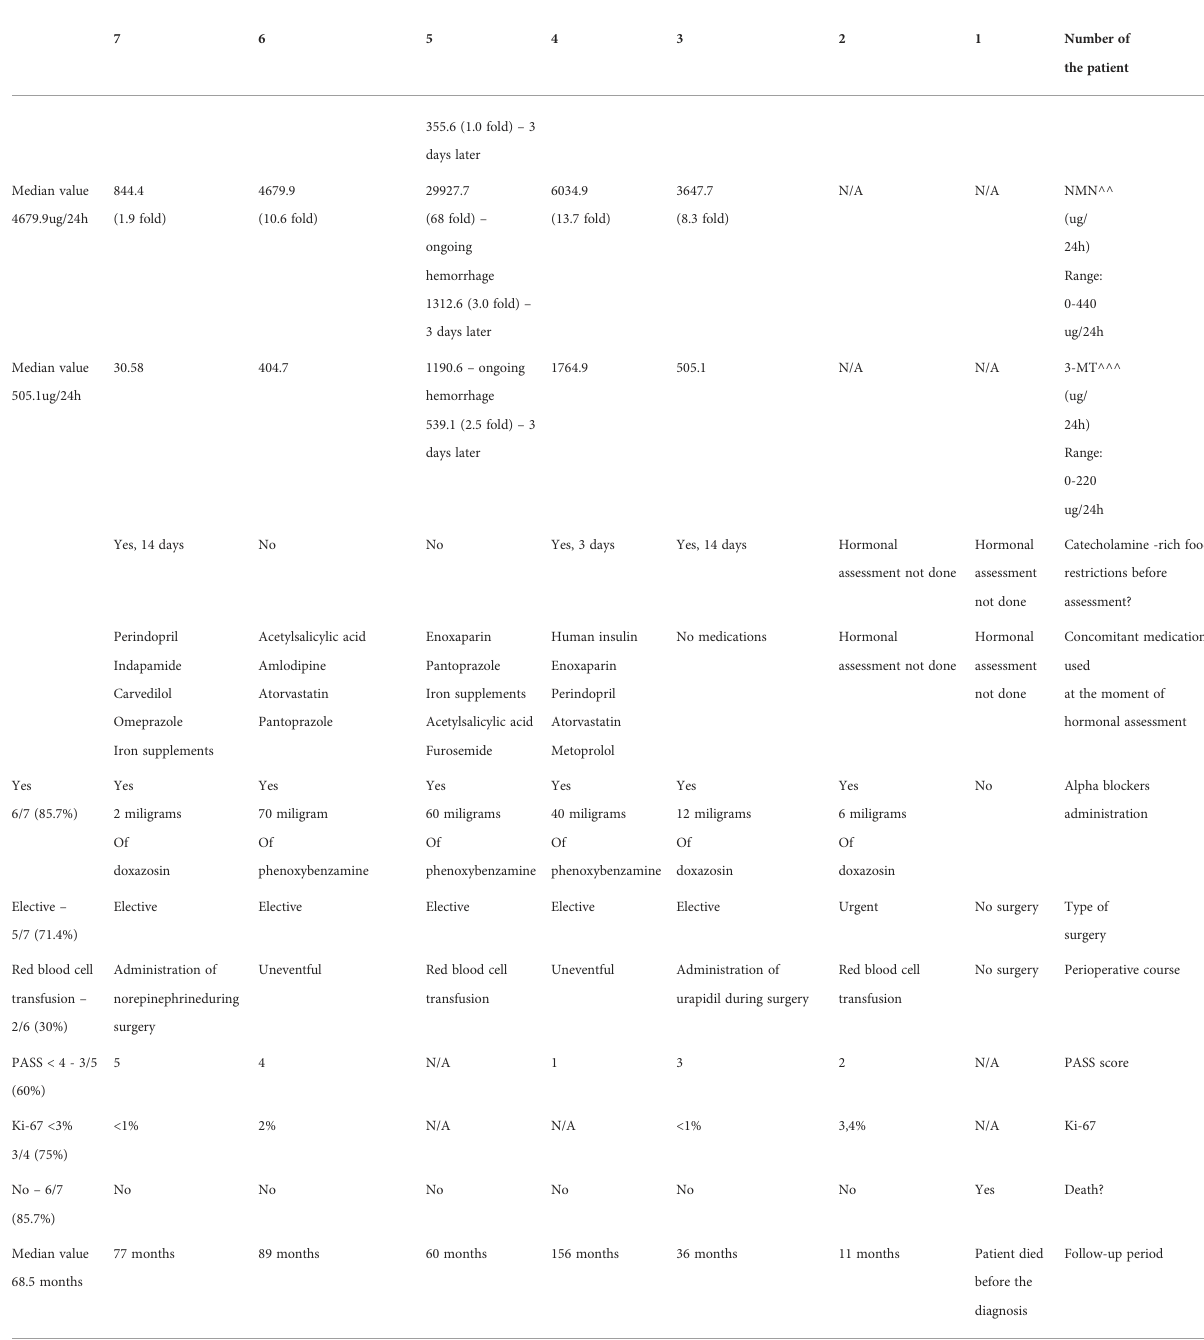
deviation. The software Statistica 13 made by StatSoft Polska in 2017 was used. Consort diagram for the study population is presented on Figure